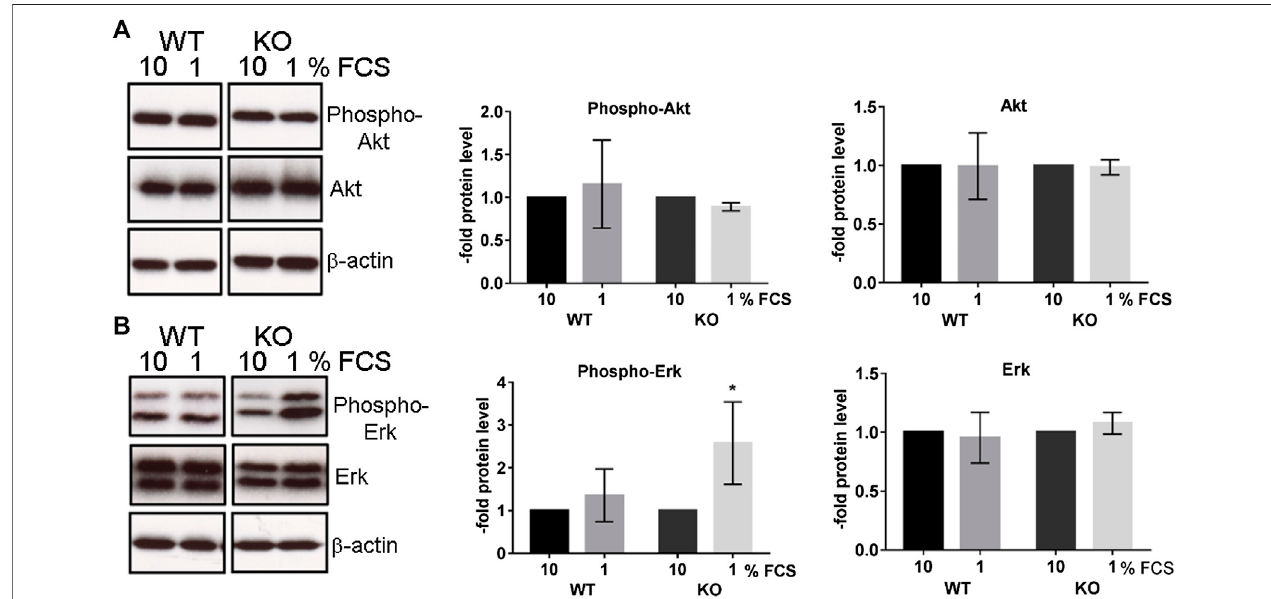
FIGURE 4 | Serum-starved PcdhgC3 knockout cells show higher phosphorylation of extracellular signal-regulated kinases (Erk). Wild type (WT) and PcdhgC3 knockout(KO)BMECsweregrowntocon fl uence,serum-starved(1%FCS)ornot(10%FCS)for24 handharvestedforproteinextractionandWesternblotanalysis. (A) Phosphorylated (Phospho-Akt) and total Akt (B) phosphorylated Erk (Phospho-Erk) and total Erk were detected with speci fi c antibodies. The protein levels were analyzed by densitometry. Data are shown as mean ± standard deviation of three independent experiments. * p <